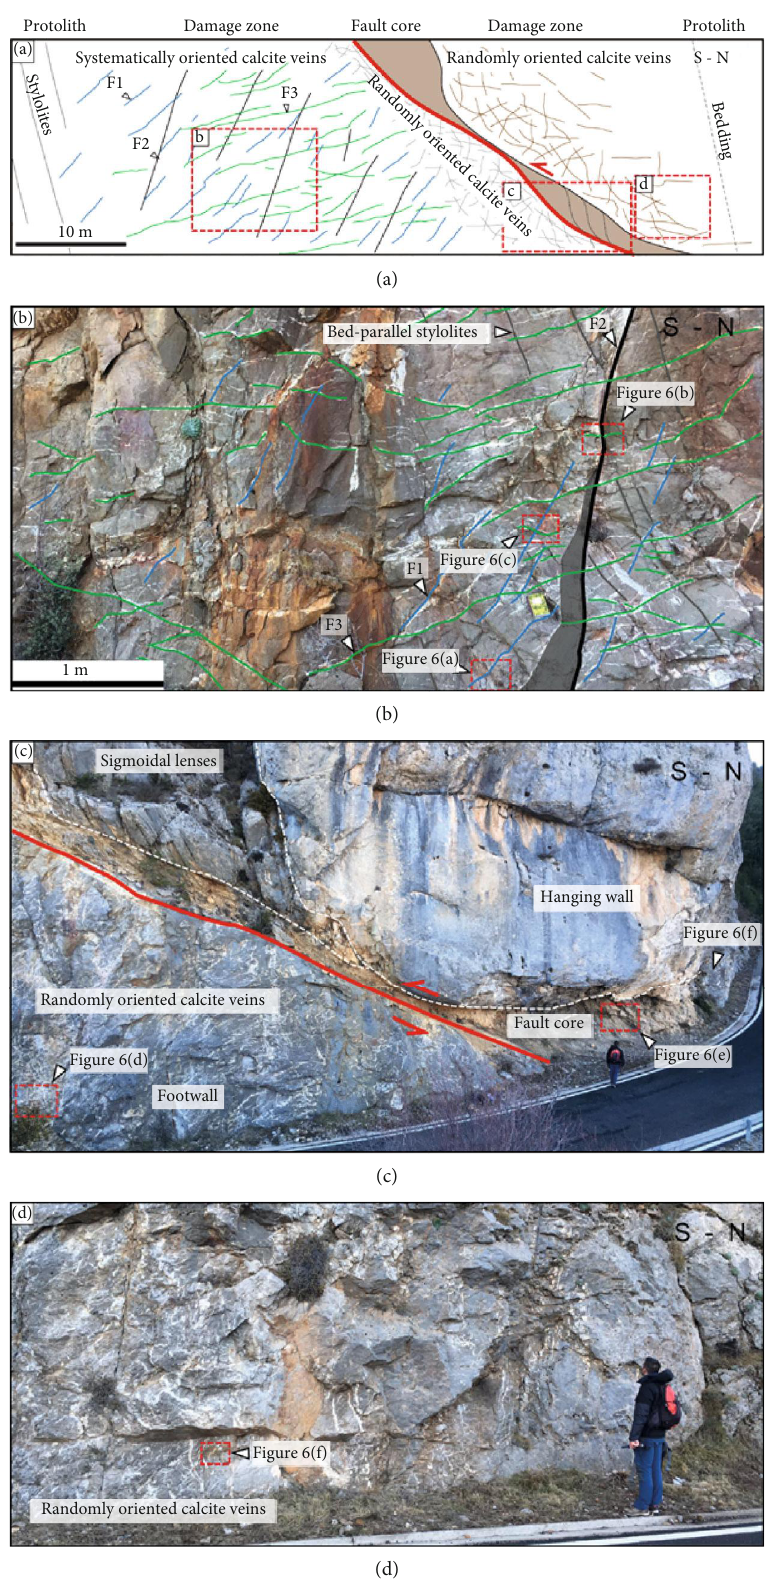
Figure 5: (a) Sketch of the spatial distribution of veins within the outcrop. In the footwall, three systematically oriented vein systems (F1 to F3) (b) evolve to randomly oriented veins located next to the fault core (c). In the hanging wall, only randomly oriented veins are observed